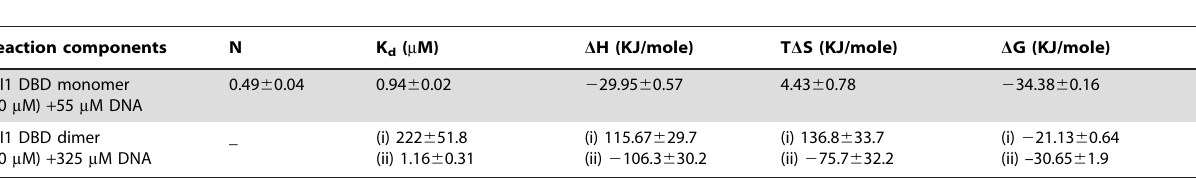
N=stoichiometry, 6 =SE (standard error). doi:10.1371/journal.pone.0066581.t002 PLOS ONE |